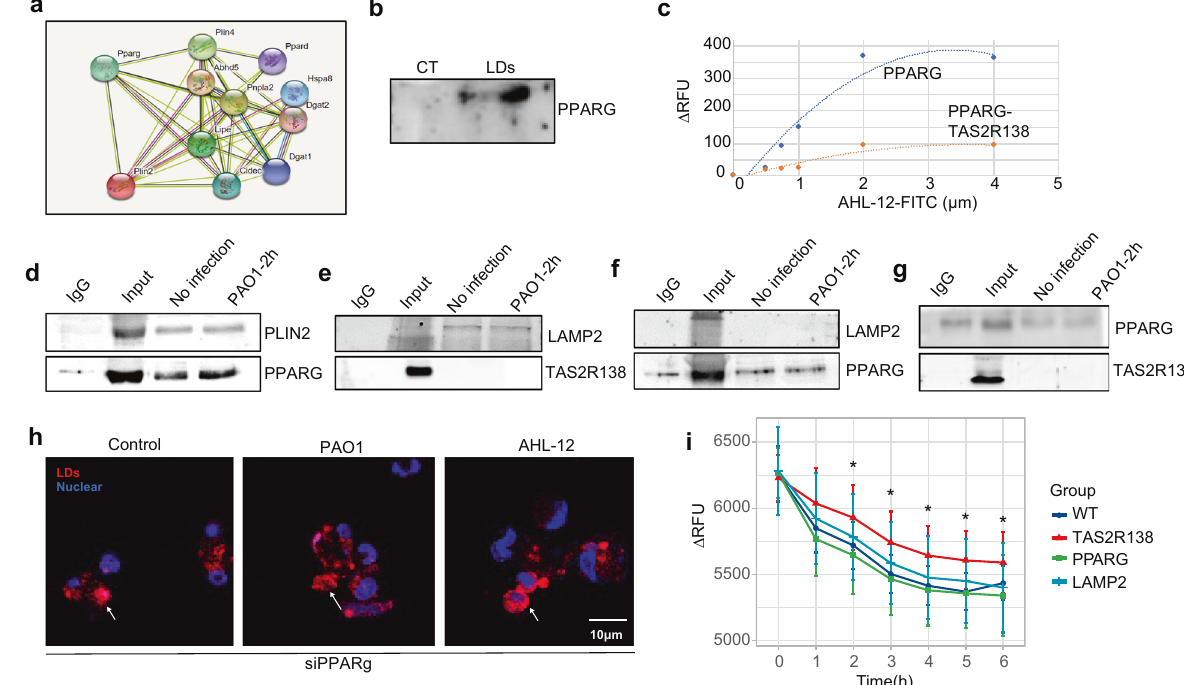
Fig. 5 PPARG bound to LDs ’ surface protein PLIN2 to facilitate lipid droplet degradation and AHL-12 clearance. a A potential interaction between PLIN2 and PPARG in mouse was predicted by “ STRING ” online on 11/19/2019. b LDs were isolated from normal or infected neutrophils, and PPARG on the LDs was detected by western blotting. c PPARG protein was coated on the plate using ELISA kit, co-cultured with different concentrations of AHL-12 – FITC individually or AHL-12 – FITC and TAS2R138 protein together for 2 h. The unbound AHL-12 – FITC was washed out, and the fl uorescence intensity was detected by a plate reader. The statistical curve corresponding to the AHL-12 – FITC concentration and fl uorescence value was fi tted. d – g Dynabeads were incubated with antibodies (PLIN2/PPARG: PLIN2 and PPARG as the probe antibody individually to pull down each other, LAMP2/TAS2R138, LAMP2/PPARG, and PPARG/TAS2R138) individually or IgG antibody overnight at 4 °C and decant by the magnetic stand. Neutrophils were lysed and incubated with beads overnight at 4 °C. Then the proteins conjugated with beads were isolated by the magnetic stand, and corresponding proteins were measured by western blotting. h Neutrophils were transfected with PPARG siRNA for 24 h then infected with PAO1 or AHL-12. LDs were stained by Nile red (arrows showing the typical LDs). i Neutrophils cultured with or without AHL-12 – FITC and TAS2R138, PPARG, or LAMP2 antibody for 2 h. The residual AHL-12 – FITC was detected by Bio-Tek fl uorescence plate reader (530/25,590/35). When stronger fl uorescence is detected, there is more free AHL-12 in the reaction solution (due to not binding to TAS2R138). The results were expressed as the mean ± SD and the signi fi cant difference level between two groups was de fi ned by student t tests, * p <